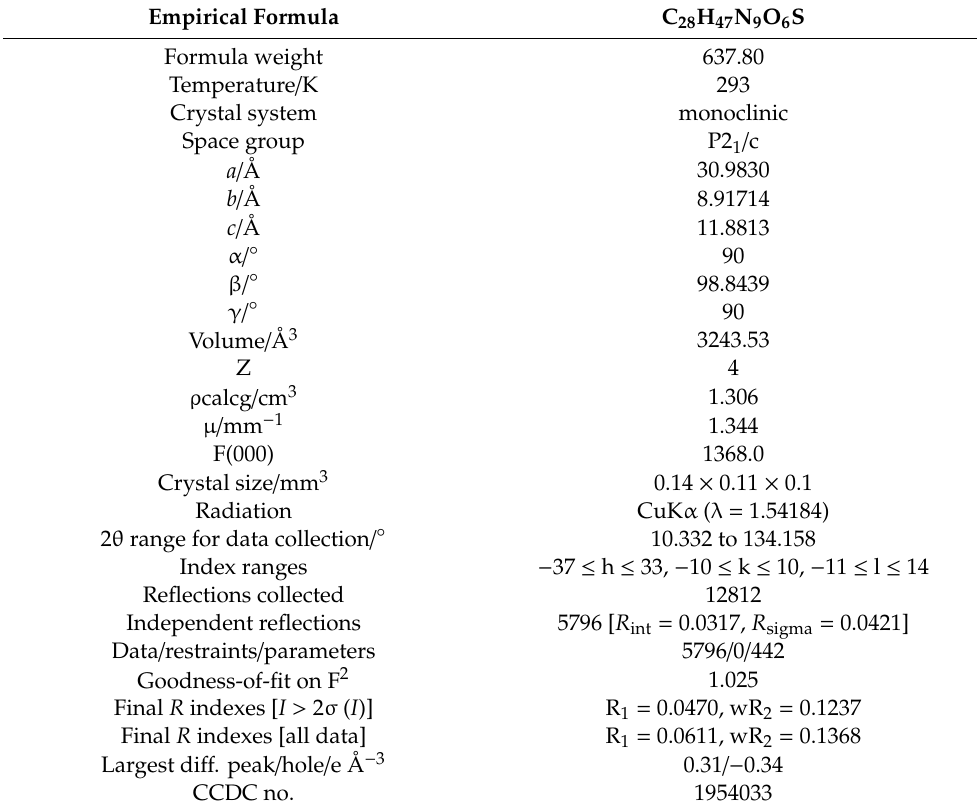
Table 1. Crystal data and structure refinement for Gli-Met.